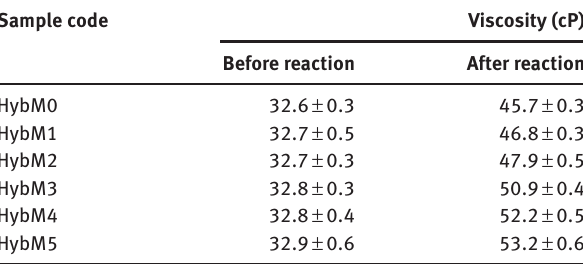
Table 2: Viscosity of hybrid nanocomposites before and after reaction. Sample code